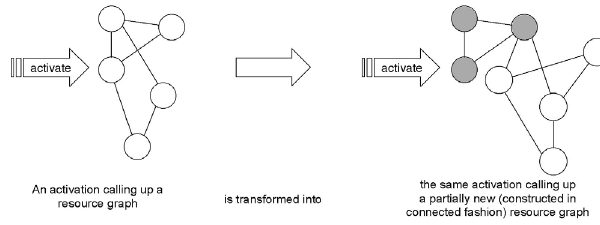
FIG. 7. Readout-cascade change. The same activation leads to a new set of linked resources.